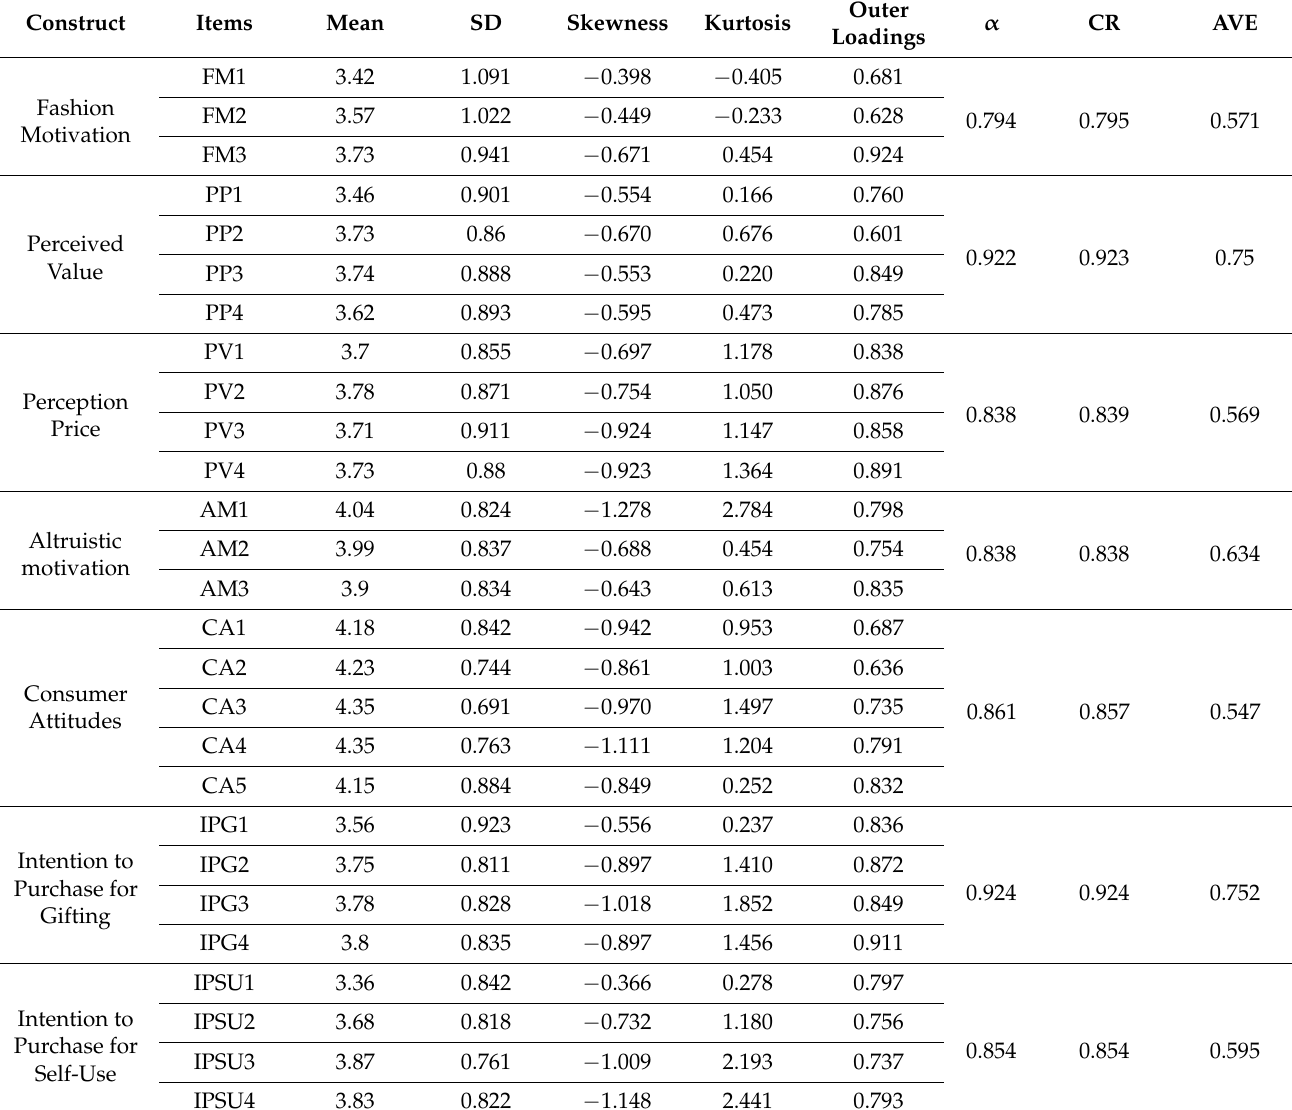
Table 1. Descriptives, validity, and reliability of measurement model (n = 289).